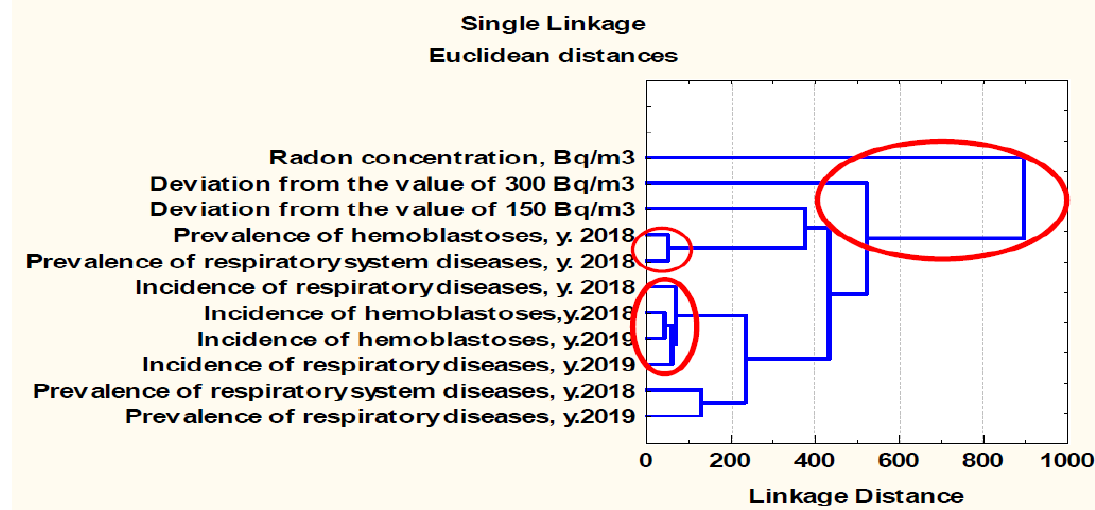
Figure 7. Cluster analysis of the interaction of factors “Concentration of radon × incidence/prevalence of diseases of the respiratory system and hemoblastoses ” .